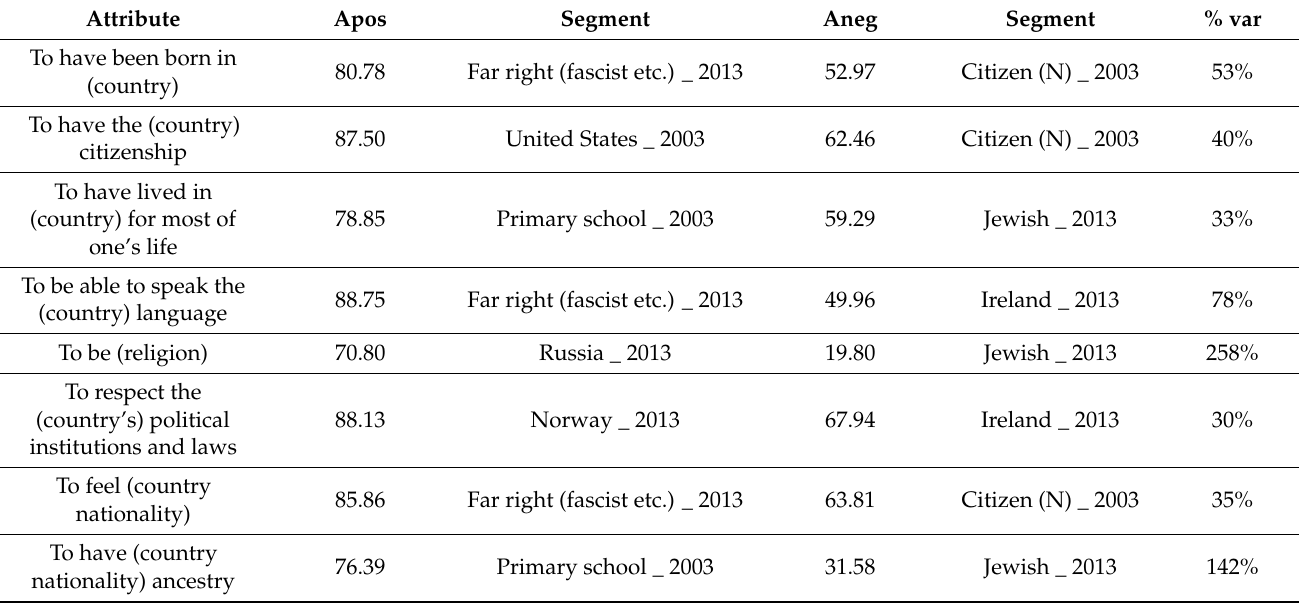
Table 3. Positive and negative ideal solutions. National identity